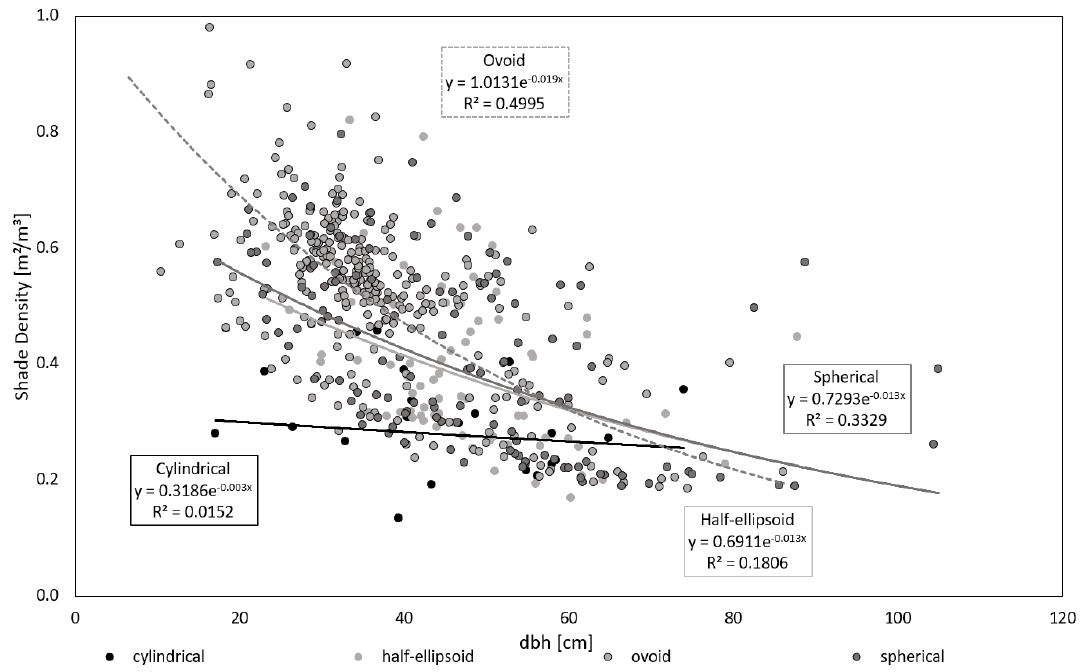
Figure 10. Dependency of shade density on tree dbh and crown shape. The mathematical constant e in the equations indicates the Euler’s number.